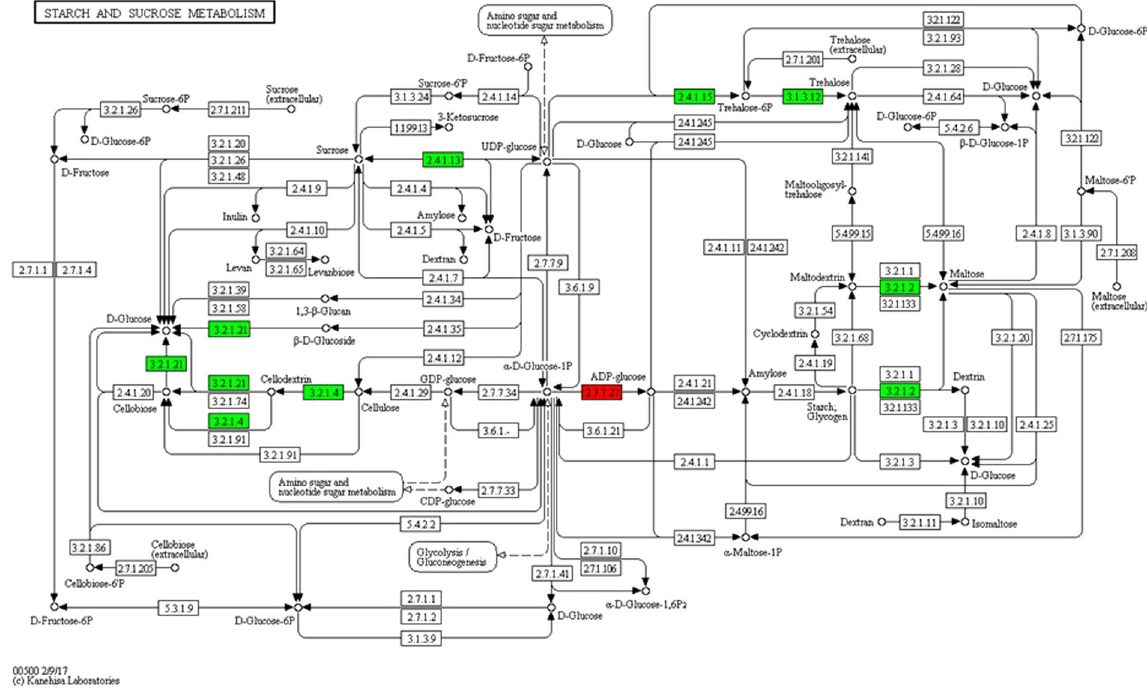
Figure 3. DEGs related to starch and sucrose metabolism were downregulated by pathogen Botryosphaeria . KEGG pathway map for starch and sucrose pathway (ko00500). Red indicates activity of the enzyme is induced by canker pathogen, while green indicates activity of the enzyme is